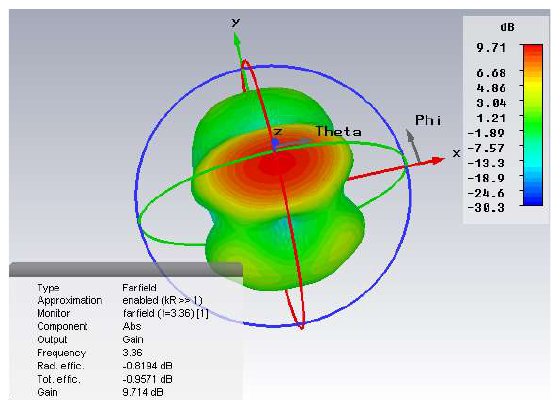
Figure 9: Radiation diagram for patch without CRR at 3.36 GHz.